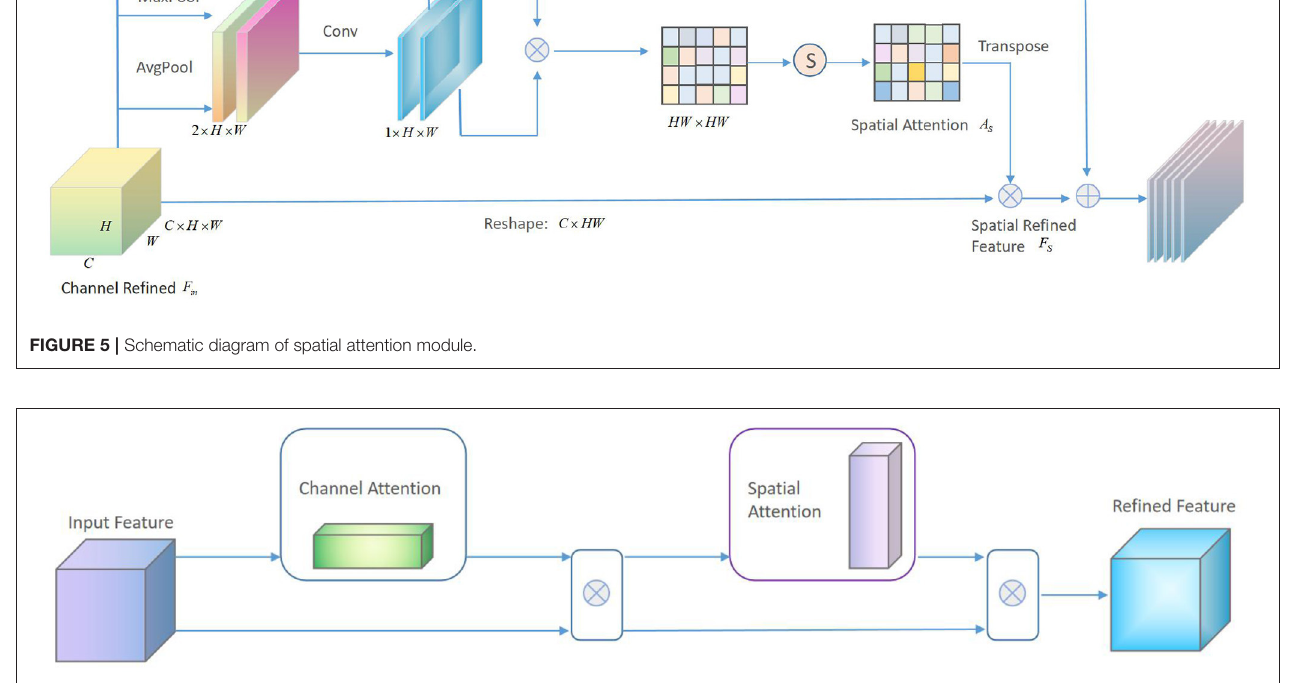
FIGURE 6 | Schematic diagram of attention